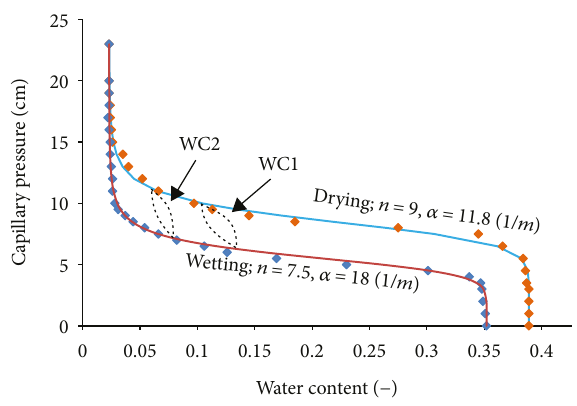
Figure 2: Drying and wetting retention curves of the sand used in experiments. The locations of the water content sensors, WC1 and WC2, are shown in Figure 1.